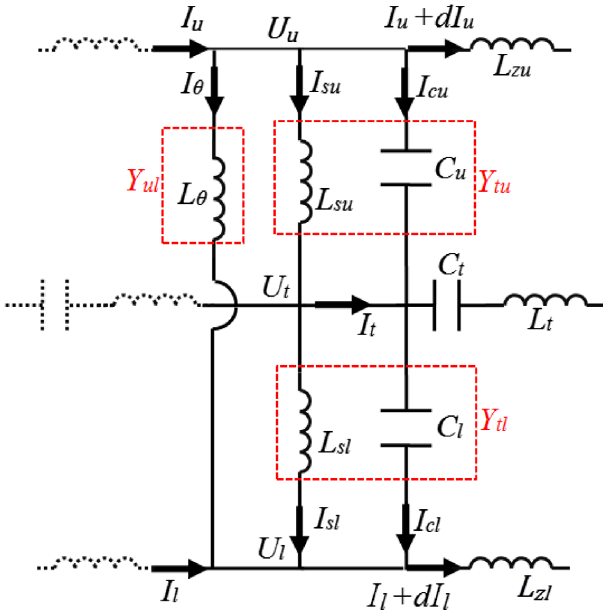
FIG. 10. Equivalent circuit for one Alvarez-type cavity cell with two half tubes, one gap, and one pair of stems (see also Fig. 4). Capacitances between tank wall and stems are merged into C and C . u l